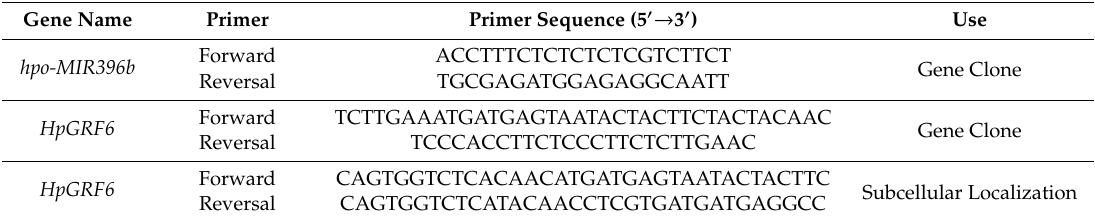
Table A2. Primer sequences used in the